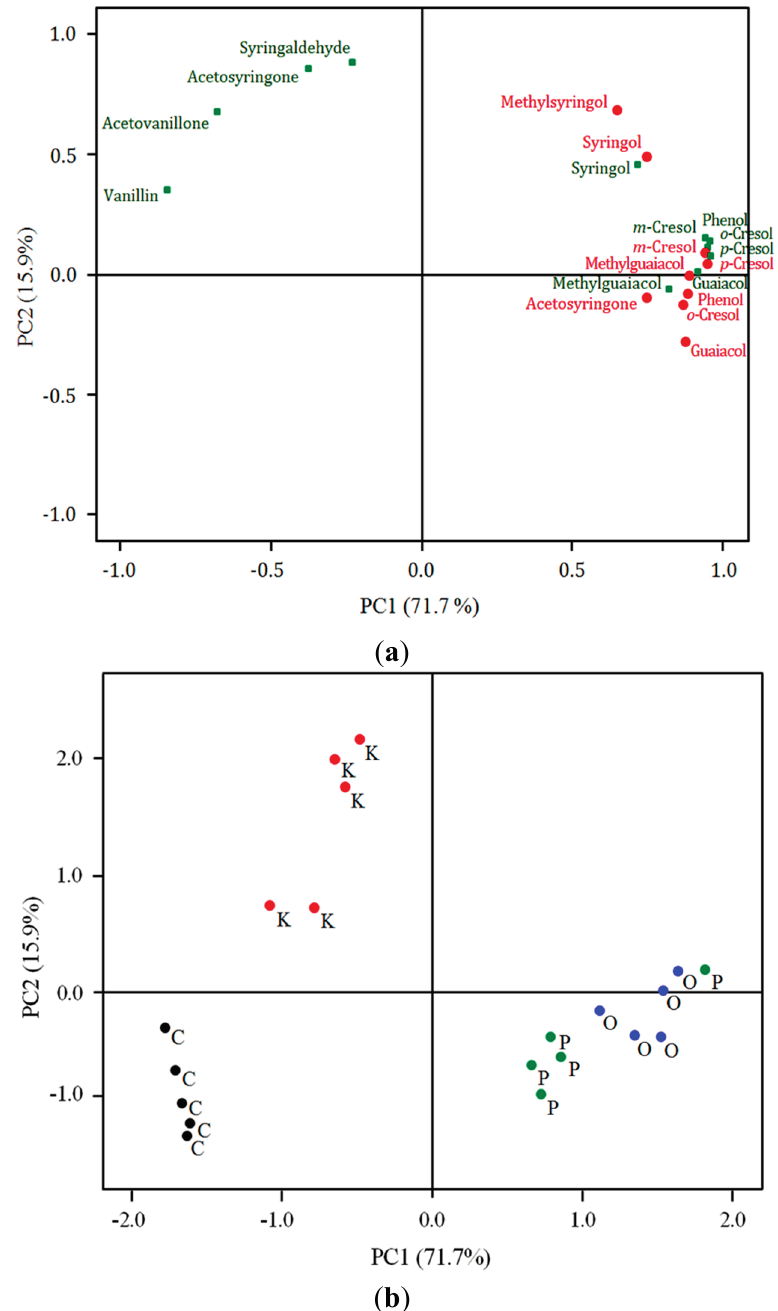
Figure 3. Separation of wines made from grapes exposed to smoke of different fuel types based on principal component analysis of wine volatile and glycoconjugated phenol composition: plots of ( a ) the vector loadings of the volatile (red circles) and glycoconjugated phenols (green squares); and ( b ) the resultant fuel treatment scores displayed on the first two principal axes of